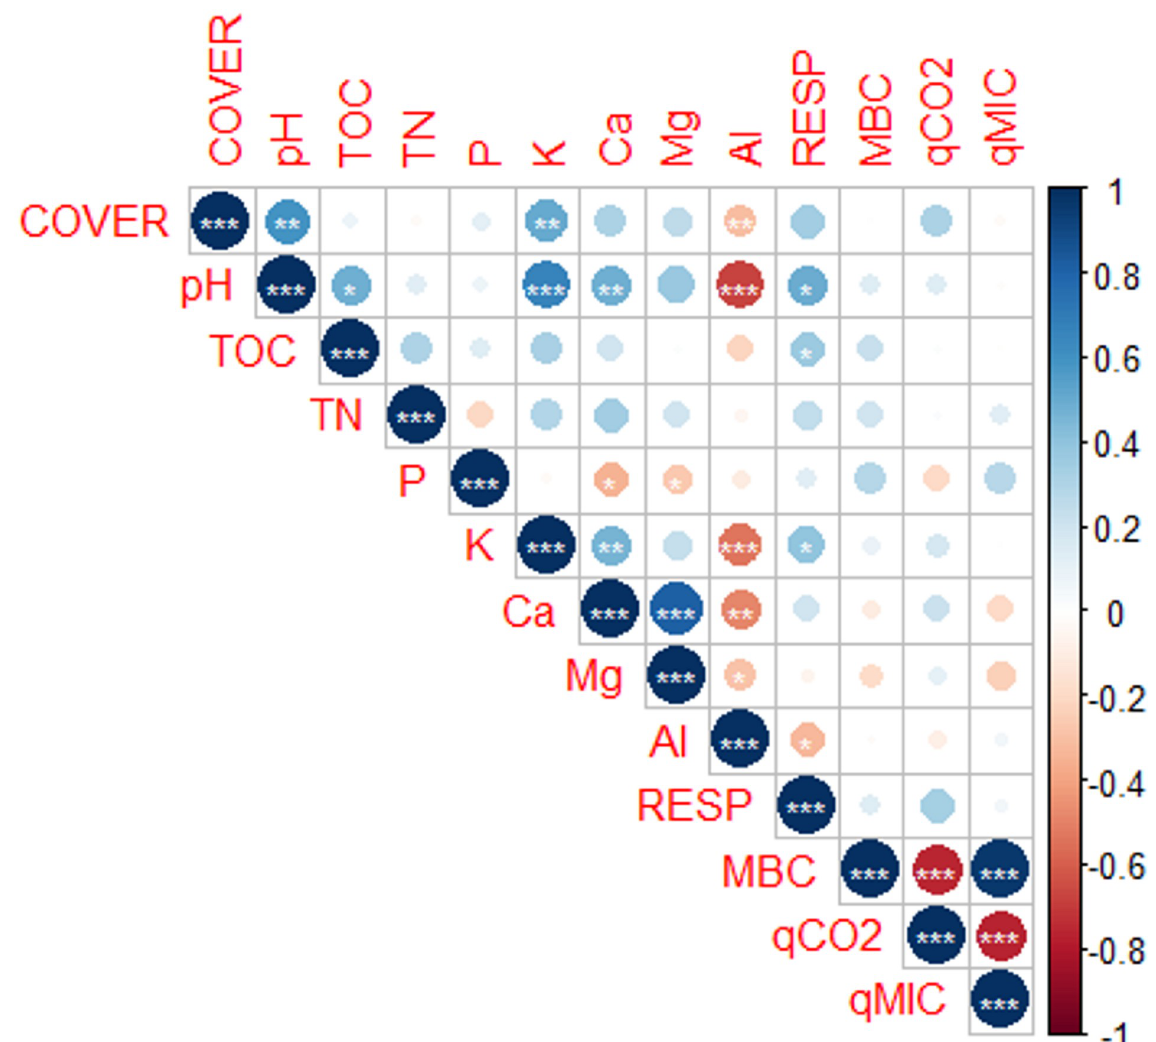
Fig 7. Correlation matrix among the variables soil cover by vegetation (COVER), pH, total organic carbon (TOC), total nitrogen (TN), phosphorus (P), potassium (K), calcium, magnesium (Mg), aluminum (Al), soil respiration (RESP), microbial biomass carbon (MBC), metabolic quotient ( q CO2), and microbial quotient ( q MIC) of the soil, across the restoration management treatments. ��� , �� and � represent significant values for p � 0.001, p � 0.01, and p � 0.05,